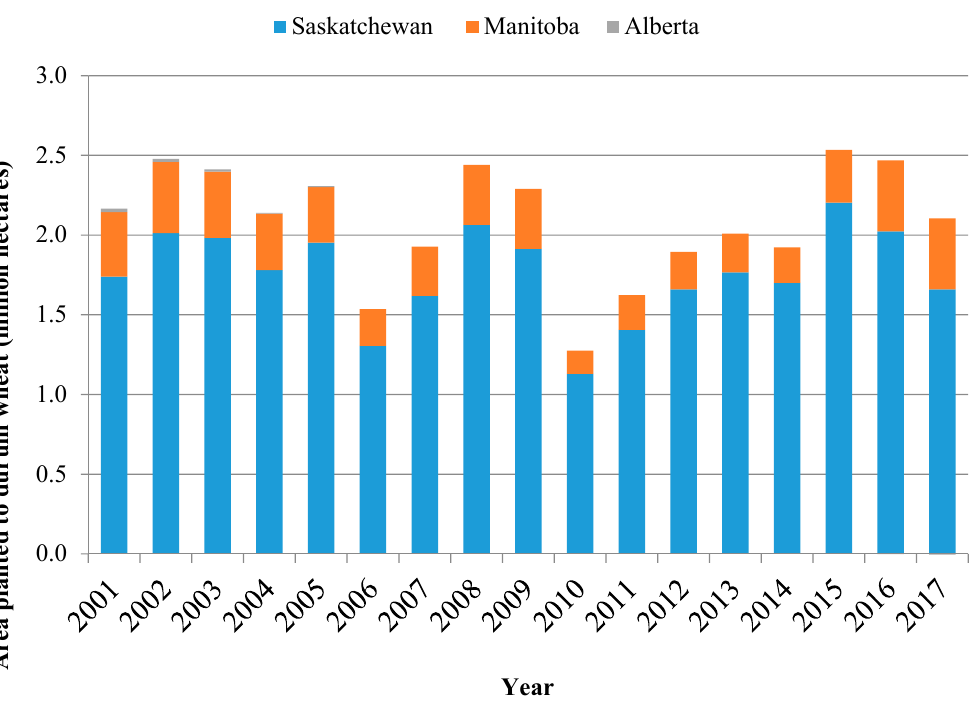
Figure 4. Distribution of durum wheat areas on the Canadian prairies [8].